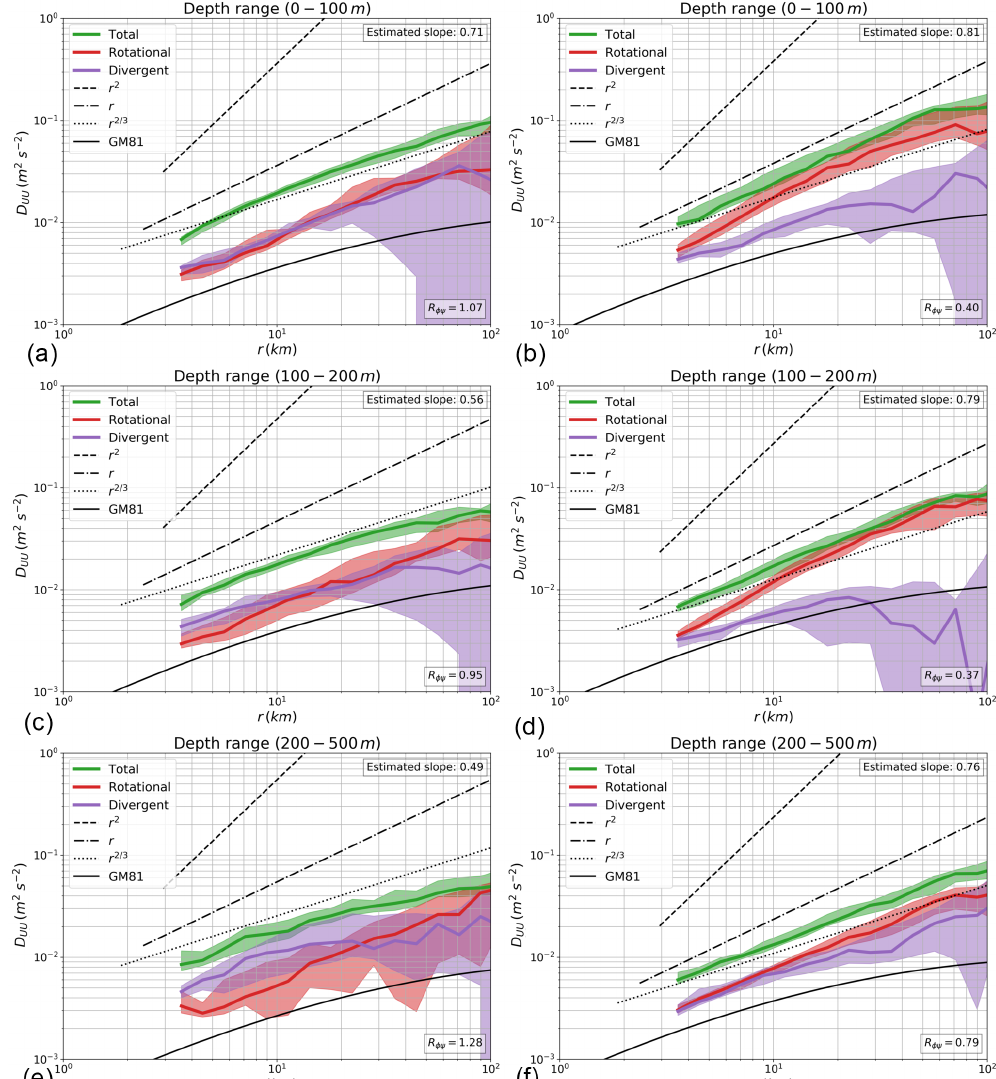
Figure 5. Same as Fig. 4 but for the NCAL (a, c, e) and SCAL (b, d, f)